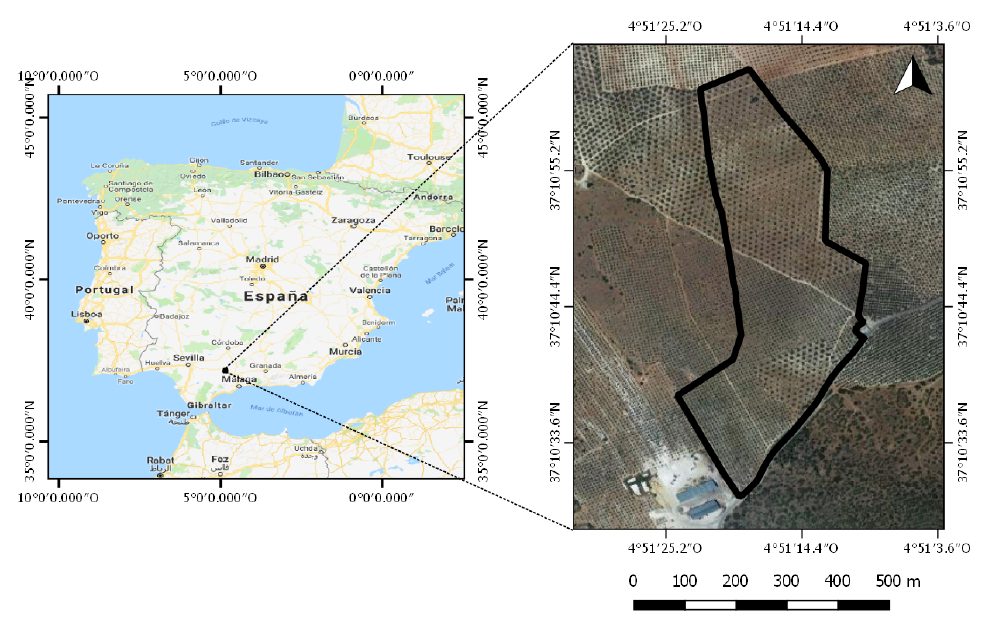
Figure 1. Aerial view of the